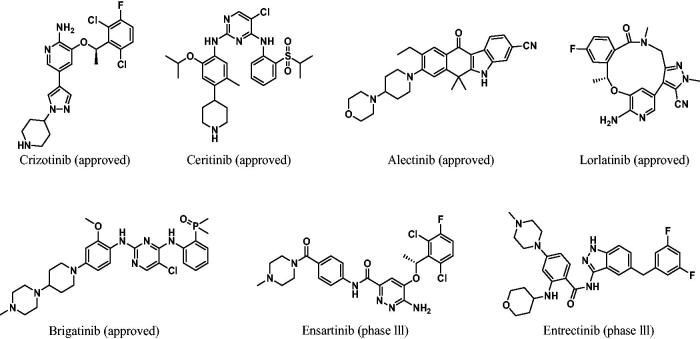
ALK inhibitors on market or under clinical trials.